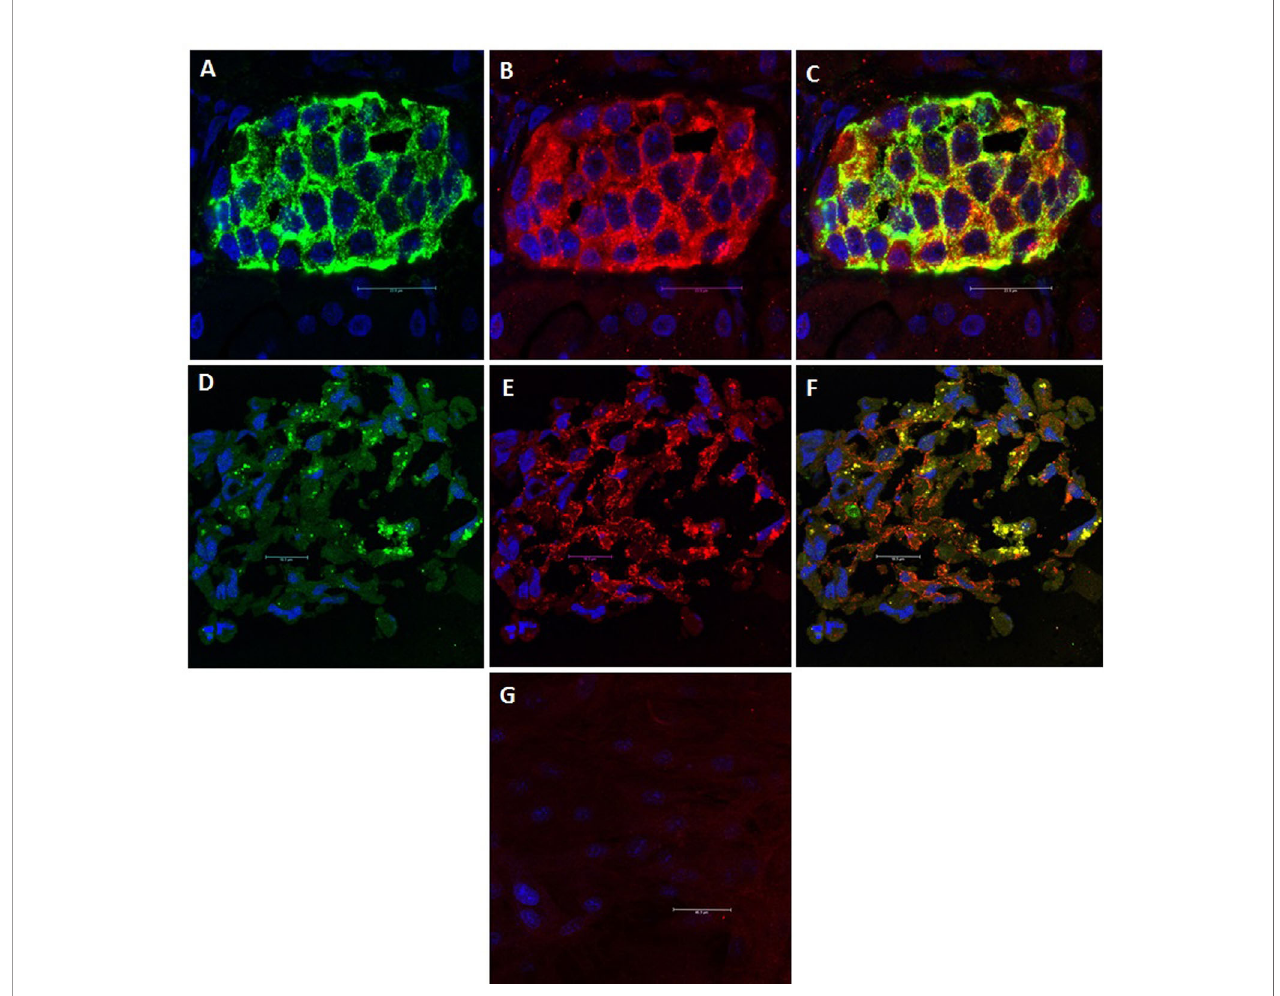
FIGURE 1 | GAD65 Expression: GAD65 converts glutamic acid into GABA, which takes part in b -cell proliferation and regeneration and glucose homeostasis. (A) Human islets: Positive staining for insulin (Green). (B) Human islets: Positive staining for GAD65 (Red). (C) Human islets: Electronic merging revealed the presence of GAD65 within the majority of insulin-producing cells (Yellow). (D) MSC-derived IPCs: Positive staining for insulin (Green). (E) MSC-derived IPCs: Positive staining for GAD65 (Red). (F) MSC-derived IPCs: Electronic merging revealed the presence of GAD65 within the majority of insulin-producing cell (Yellow). (G) Negative staining for GAD65 in undifferentiated